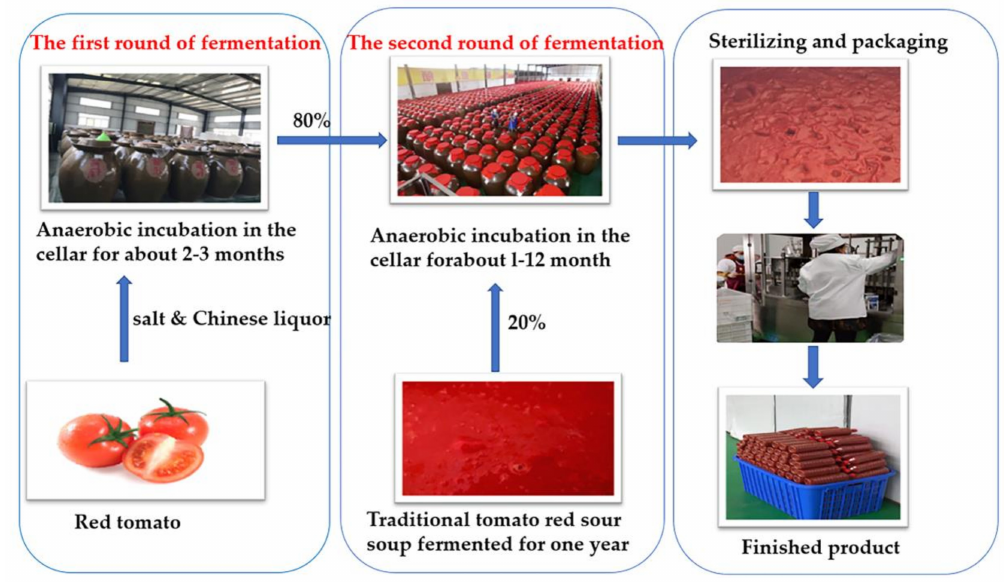
Figure 1. Production process of traditional fermented tomato sour